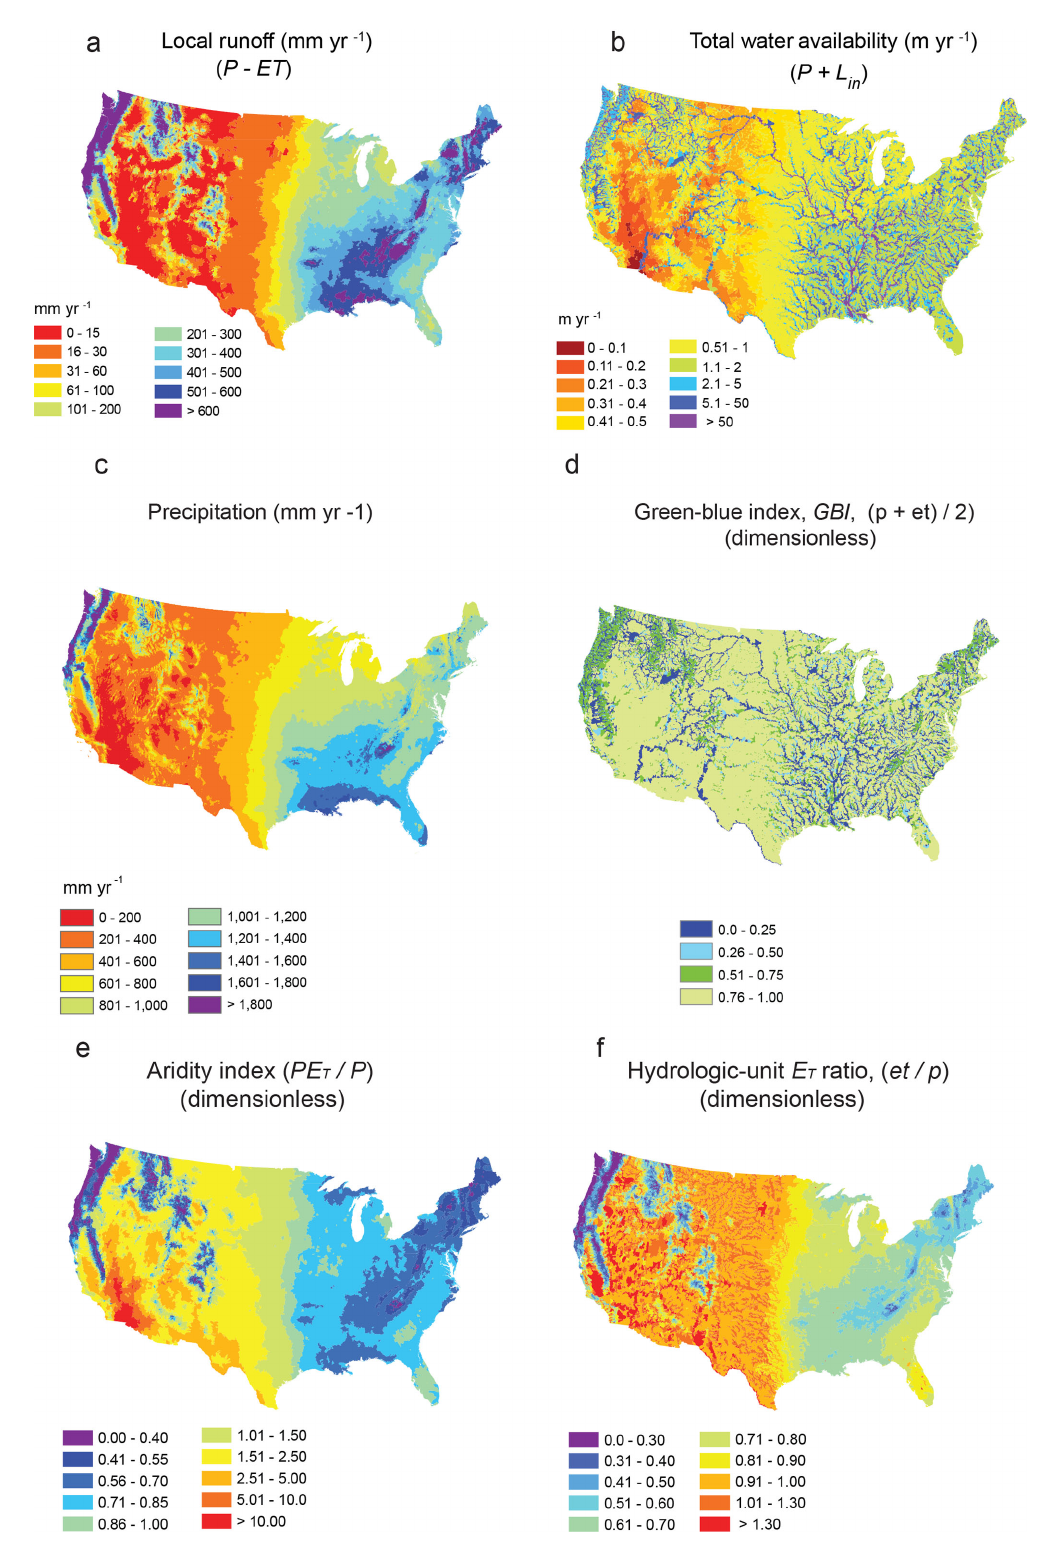
Figure 3. Classic (a, c, e) and newly introduced (b, d, f) indicators of terrestrial water availability for 53400 networked hydrologic units of the conterminous USA, on a mean-annual basis for 1896–2006. See text and Table 2 for indicator definitions. (a) Local runoff (mmyr − 1 ), and (f) hydrologic-unit-evapotranspiration ratio (et /p , dimensionless).